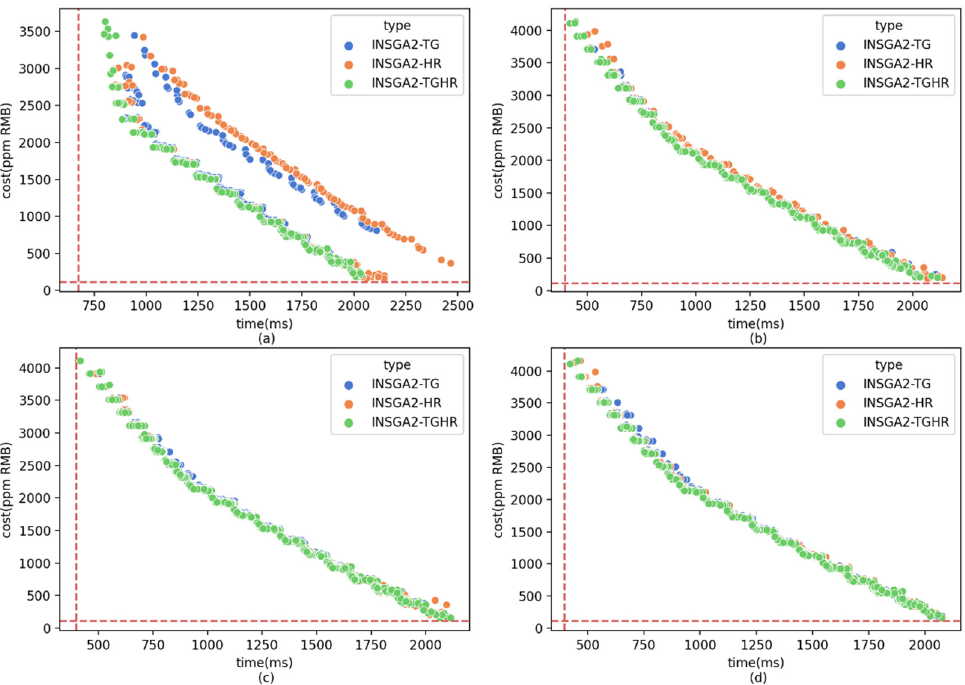
Figure 11. The Pareto frontier in different edge resources setting. ( a ), ( b ), ( c ), ( d ) are comparing different resources in (6, 1, 1), (6, 2, 1), (6, 3, 1), (6, 4, 1) settings, respectively.